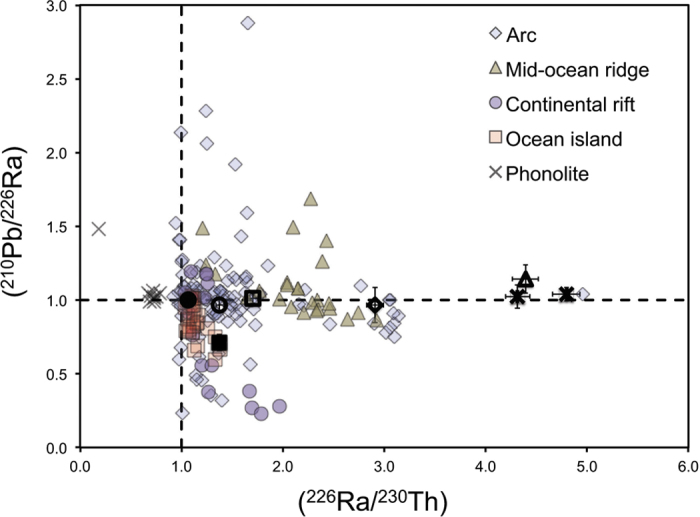
Plot of (210Pb/226Ra) versus (226Ra/230Th) showing data from this paper with error bars (island arc samples = black diamonds; ocean arc samples = black squares) and published data for lavas and tephras from a variety of tectonic settings91043444546.The phonolite whole rock from Tristan da Cunha8 and phonolite glass separates from Mount Erebus9 are shown separately because they demonstrably have had (226Ra) lowered by crystal fractionation of K-rich feldspars or amphiboles. Data were excluded for samples with unusually high Pb concentrations and high (210Pb/226Ra) values that likely reflect the assimilation of young 210Pb-enriched sublimates53647. Dashed lines denote secular equilibrium. Arcs have wide-ranging (210Pb/226Ra) values but have a median value of equilibrium, whereas ocean island basalts have a median value of 0.76, and rarely have 210Pb excesses. We attribute these variations to differences and volatile profiles and modes of degassing in these different tectonic settings. See text for further explanation.